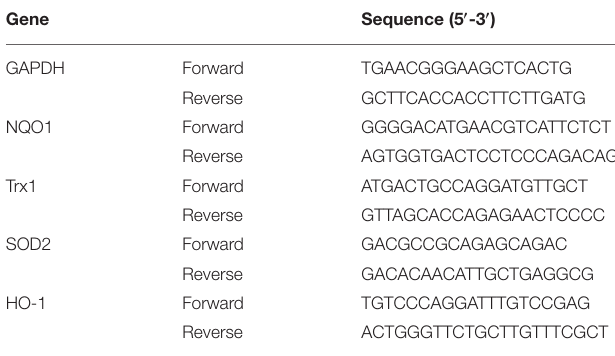
TABLE 2 | Rat Primers used in quantitative-polymerase chain reaction (Q-PCR).